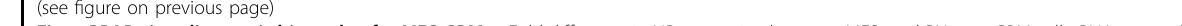
Fig. 1 PPAR γ is a diagnostic biomarker for MES GBM. a Fold difference in NR expression between MES- and PN-type GBM cells. RNA-seq analysis was performed for two MES (83 and 1123) and one PN (X01) type of GSC. b , c Characterization of GSCs. b Morphological features of four PN types (448T, X01, X02, and 528) and three MES types (0502, 1123, and 83) of GSCs. c Relative mRNA expression of biomarkers representing PN- and MES- type GBM in the panel of cell lines. A relative RT-PCR assay was carried out to measure the mRNA expression of biomarkers for PN (SOX2 and OLIG2) and MES (CD44, BCL2A1, ALDH1A3, and WT1) in the panel. The graph shows the mean ± S.E.M. ( n = 3). d Both mRNA and protein expression of PPAR γ are shown along with representative biomarkers in the GSC panel. The graph shows the mean ± S.E.M. ( n = 3). e Identi fi cation of MES-featured PPAR γ expression using public GBM datasets. PPAR γ expression was analyzed in PN and MES types using public GEO (left) of TCGA databases (right). Each dot in the box represents individual GSC samples (left, n = 10) or tumor tissues (right, n = 112). The line indicates median expression in each group. f Pearson correlation of PPAR γ expression to GBM biomarkers. PPAR γ expression is positively correlated with MES markers (CD44, BCL2A1, ALDH1A3, and WT1) but negatively correlated with PN markers (SOX2 and OLIG2) when analyzed in the database from TCGA. Note that r and P represent the Pearson correlation coef fi cient and statistical signi fi cance,